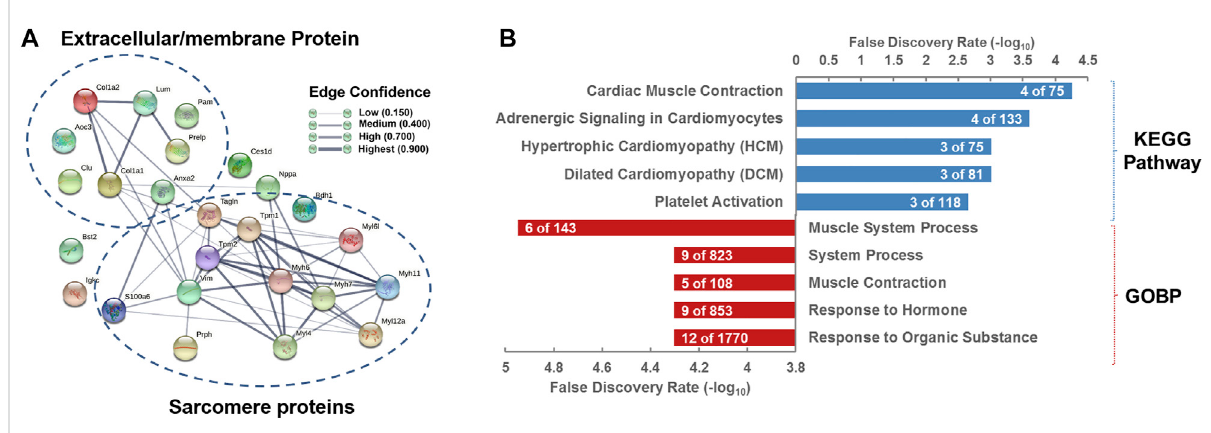
FIGURE 6 Bioinformatics analysis of differentially expressed proteins (DEPs) in the hearts of rats with ISO-iCM compared to the controls (A) Protein – protein interaction network of the 25 DEPs. (B) KEGG pathways and biological processes in which the 25 DEPs are associated